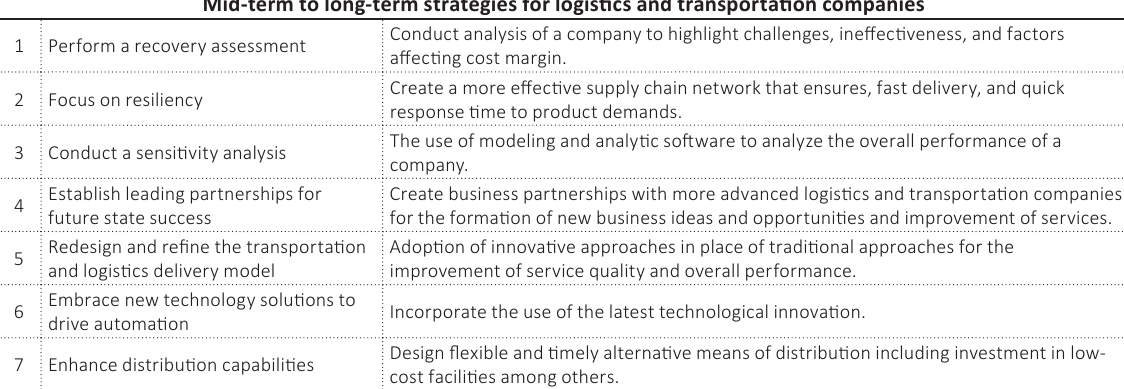
Table 3. Mid-term to long-term strategies for logistics and transportation companies to curb the impact of the COVID-19